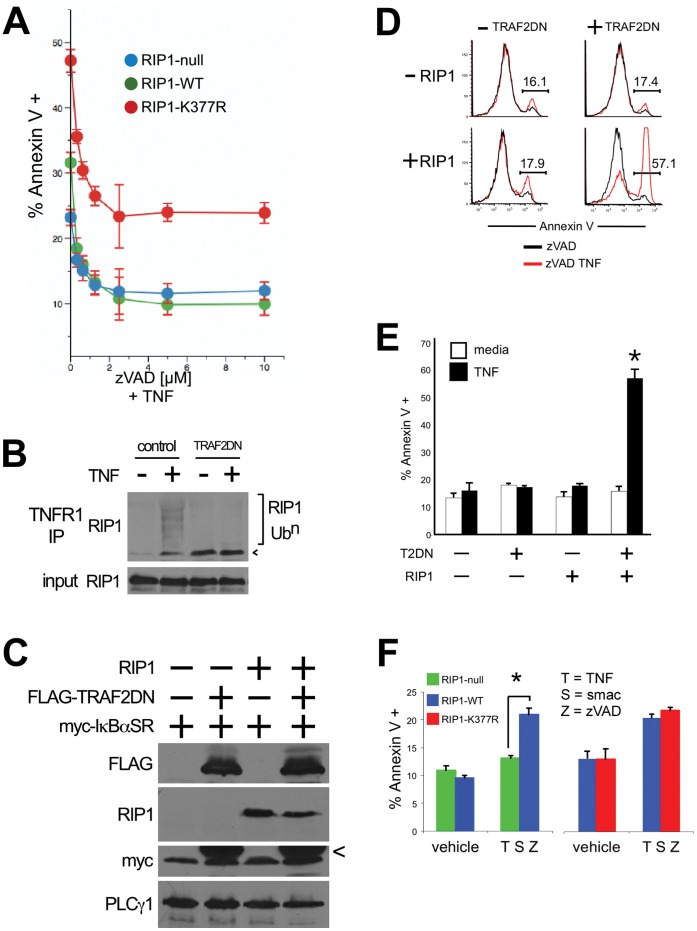
Ubiquitination of RIP1 prevents programmed necrosis.(A) RIP1-null Jurkat T cells were transduced with either a control protein, RIP1-WT or RIP1-K377R. Cells were pre-treated for one hour with different doses of zVAD and then stimulated with 10 ng/ml TNF for 24 hours. Cell death was quantified by Annexin V staining and flow cytometry. (B) Parental 3T8 Jurkat T cells were transduced with either a control protein or the TRAF2 dominant negative (TRAF2DN). Cells were stimulated with 100 ng/ml TNF for 5 minutes and the TNFR1 complex was immunoprecipitated and subject to western blot with antibodies specific to RIP1. A sample of the lysate before immunoprecipitation (input) was blotted for RIP1 as a loading control. (C) RIP1-null cells were transduced with a control protein (- RIP1) or RIP1-WT (+ RIP1) and then subsequently transduced with a control protein (- TRAF2DN) or the TRAF2DN protein (+ TRAF2DN). All four cell lines were transduced with the IκBαSR. Expression of all transgenes was confirmed by western blot (< marks remaining signal from the TRAF2DN blot) (D) The cells in (C) were pre-treated with 10 µM zVAD for one hour and stimulated with 10 ng/ml TNF. Cell death was measured after 24 hours as described in (A). Representative histograms are shown in (D): the number above the gate indicates the percentage cells that stain with Annexin V after TNF treatment. (E) The bar chart displays the mean percentage of Annexin V staining cells and the SEM of three independent experiments performed as described in (D), * denotes p<0.05. (F) Bar chart shows programmed necrosis in RIP1-null cells reconstituted with either a control protein, RIP1-WT or RIP1-K377R after treatment with 100 nM SMAC mimetic (S) and 10 µM zVAD (Z) for one hour prior to stimulation with 10 ng/ml TNF (T). Cell death was measured after 24 hours as described; the mean percentage of Annexin V staining cells and STD of 3 independent experiments is shown, * denotes p<0.01. All cell lines in Figure 3 express NEMO.